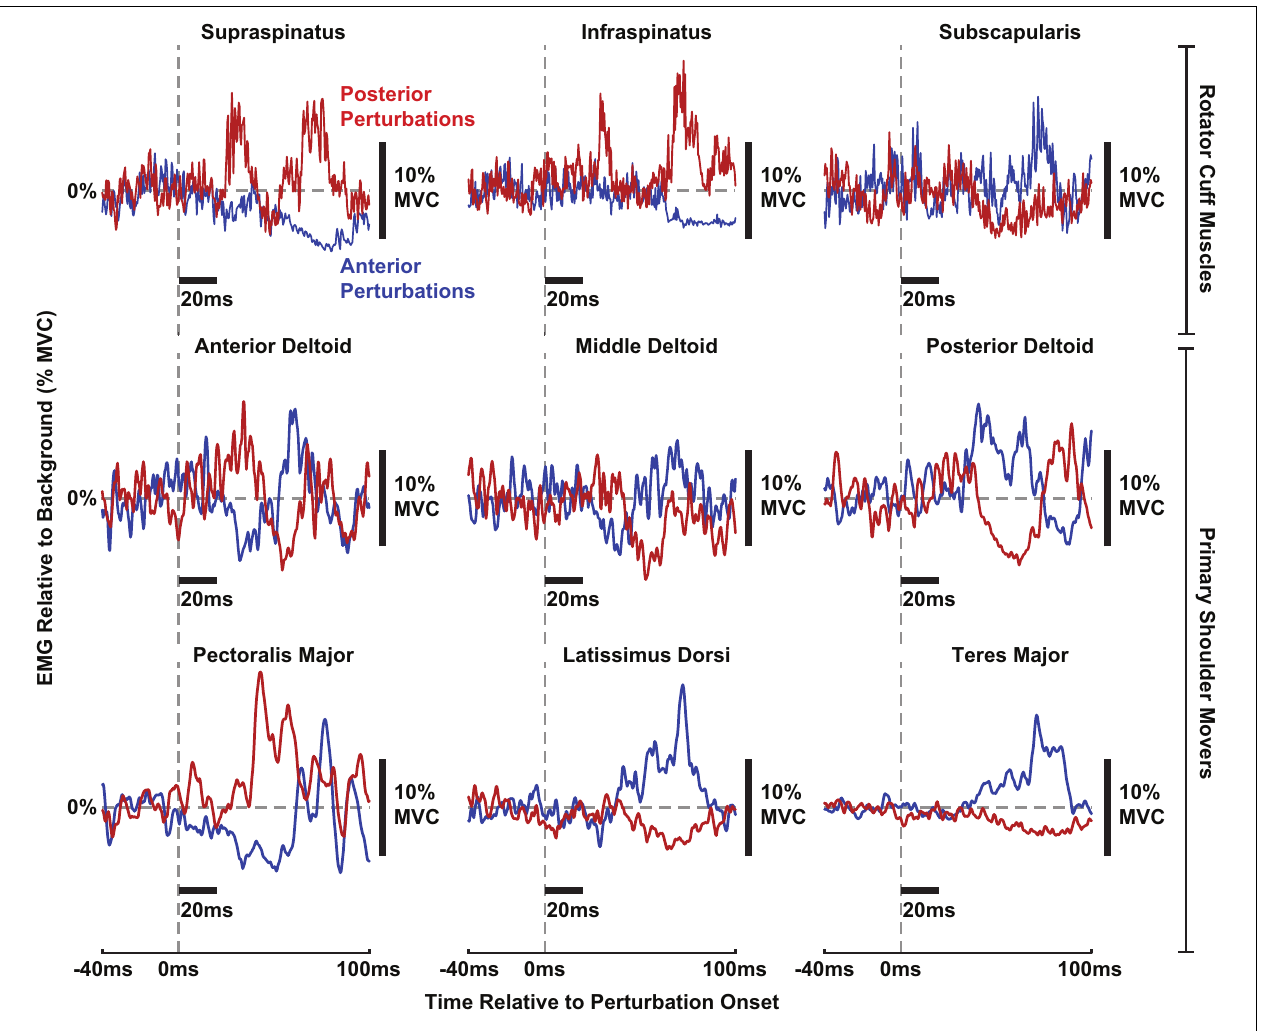
FIGURE 3 | Individual stretch-evoked reflexes responding to anterior (blue) and posterior (red) perturbations in all muscles from a typical participant. All trials shown are from torque levels of 10% MVC in a torque direction that generated a large background activity for each muscle. All EMGs are displayed relative to background activity. Thick black bars are included to display the scale of the x-axes (20 ms per horizontal bar) and y-axes (10% MVC of ∆ EMG per vertical bar),